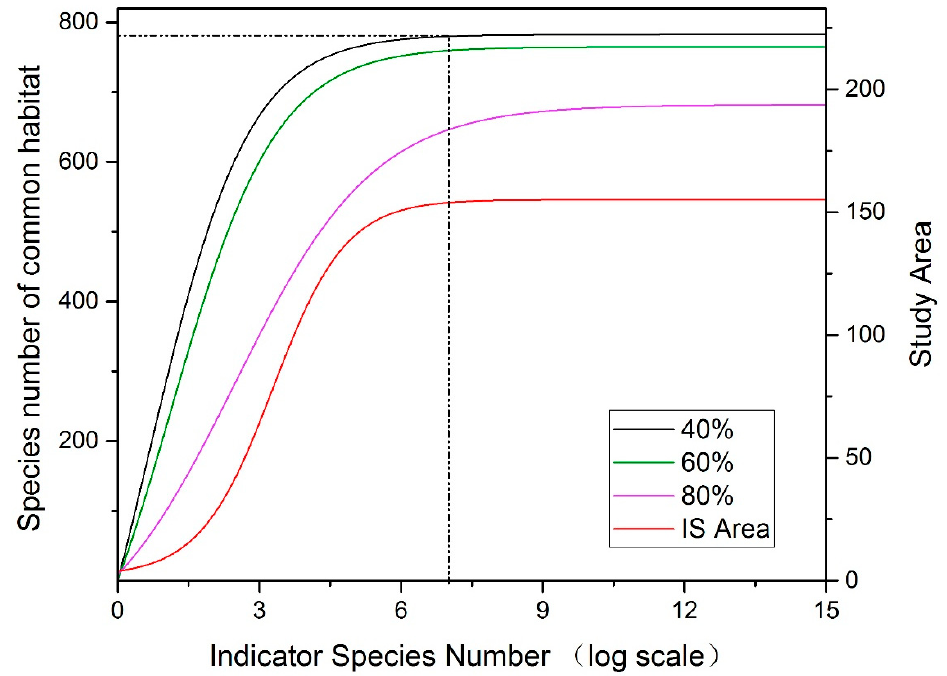
Figure 4. Number of species with habitats that overlapped with indicator species. IS area: indicator species habitat area.